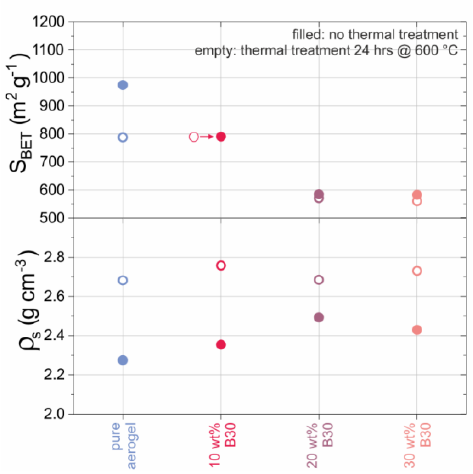
Figure 6. Comparison of the skeletal density and the specific surface area of the pure SA without and with various amounts of B30. (S BET data point for 10 wt.% B30 after heat treatment was shifted to the left for reasons of visibility) .